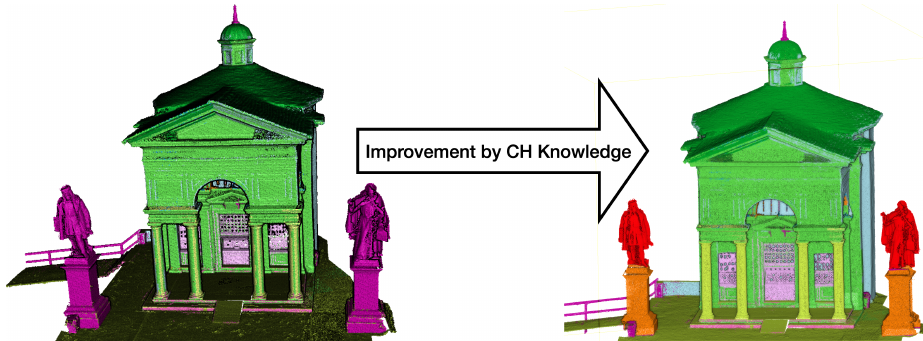
Figure 11. Results of the object recognition improved by cultural heritage (CH) knowledge.